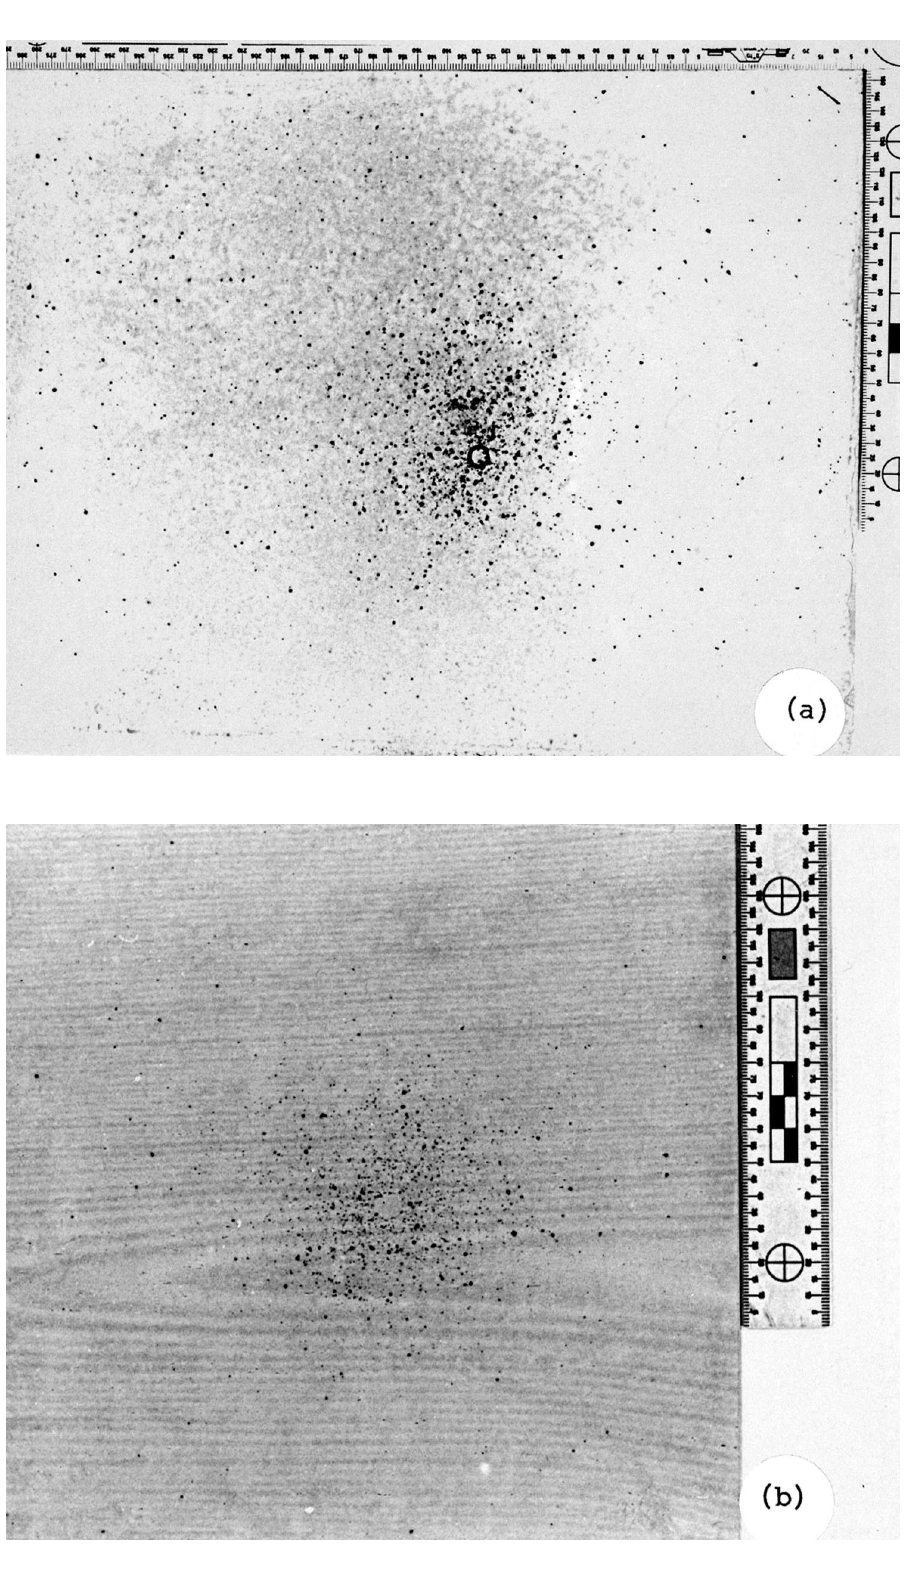
FIGURE 4 . Black and white photograph of the visualized total nitrite patterns on the adhesive lifters applied to various target materials after shooting (ammunition 9-mm parabellum FMJ, distance 25 cm). (a) White cotton cloth. (b) Plywood. (c)